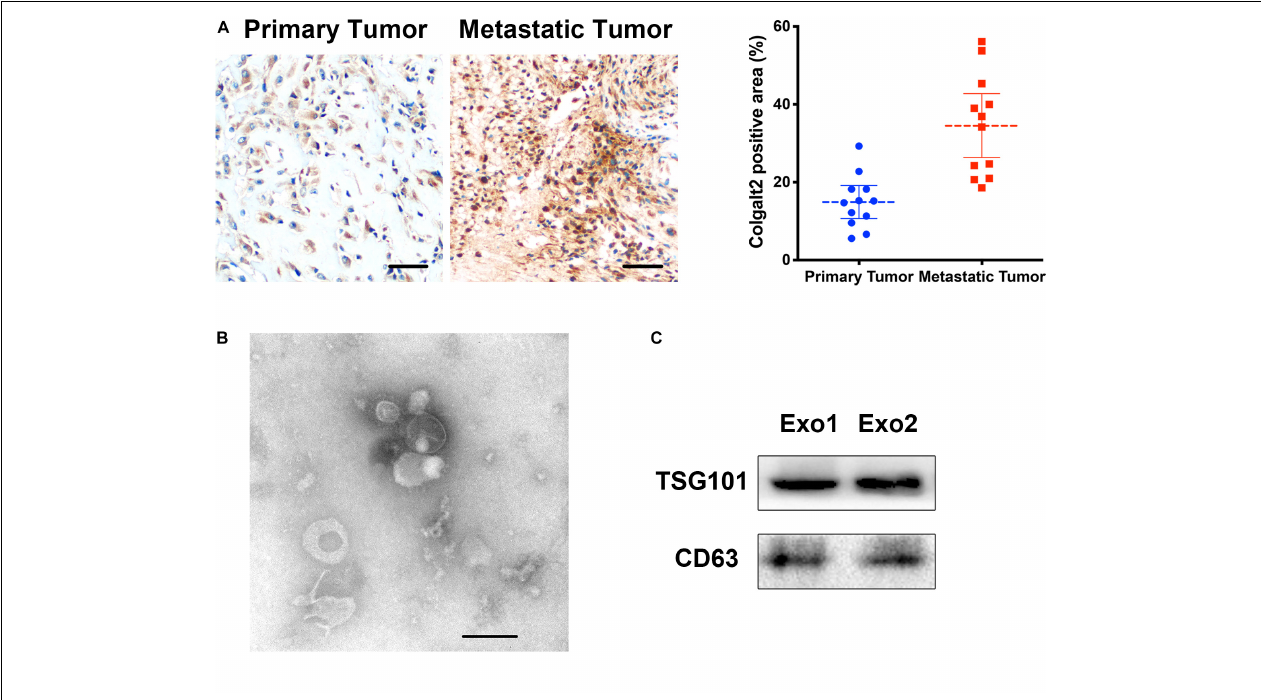
FIGURE 1 | COLGALT2 overexpression in metastatic osteosarcoma tissues and ADSC exosome characterization. (A) Immunohistochemical analysis of COLGALT2 protein expression in human primary and metastatic osteosarcoma tissues. (B) ADSC exosomes were visualized by electron microscopy ( × 30,000). Scale bar = 100 nm. (C) Western blotting shows that ADSC exosomes expressed exosome-associated proteins, including CD63 and